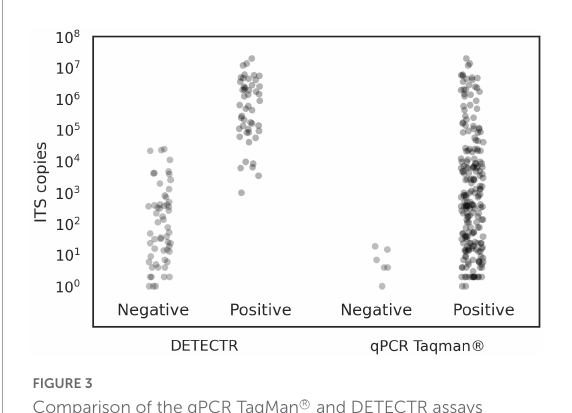
FIGURE3 Comparison of the qPCR TaqMan R (cid:13) and DETECTR assays sensitivity when detecting various sample types. The scatter plot depicted here suggests that the lower detection limit of the DETECTR test is much higher than that of the qPCR TaqMan R (cid:13)